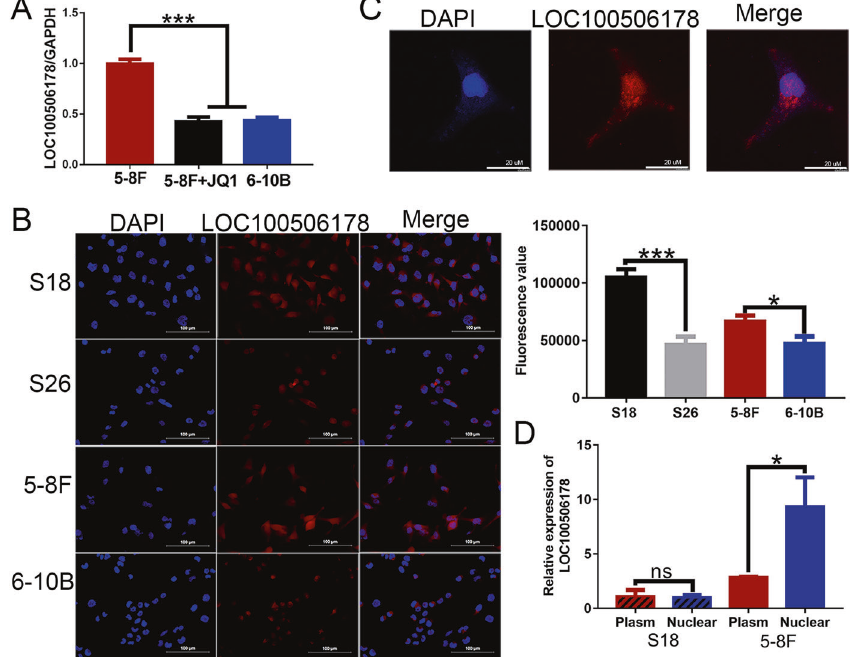
Fig. 3 The expression of seRNA LOC100506178 in NPC cells. A The transcription of seRNA LOC100506178 was detected with RT-qPCR in 5 – 8 F, JQ1-treated 5 – 8 F, and 6-10B cells. B RNA FISH was carried out to verify the location and relative levels of seRNA LOC100506178 in S18, S26, 5 – 8 F, and 6-10B cells; the fl uorescence intensity was presented as the means ± S.E.M of three independent experiments. C The location of seRNA LOC100506178 was detected using CLSM. D The cytoplasmic and nuclear RNA in S18 and 5 – 8 F cells was isolated and detected. *** P < 0.001; * P < 0.05; ns, P >